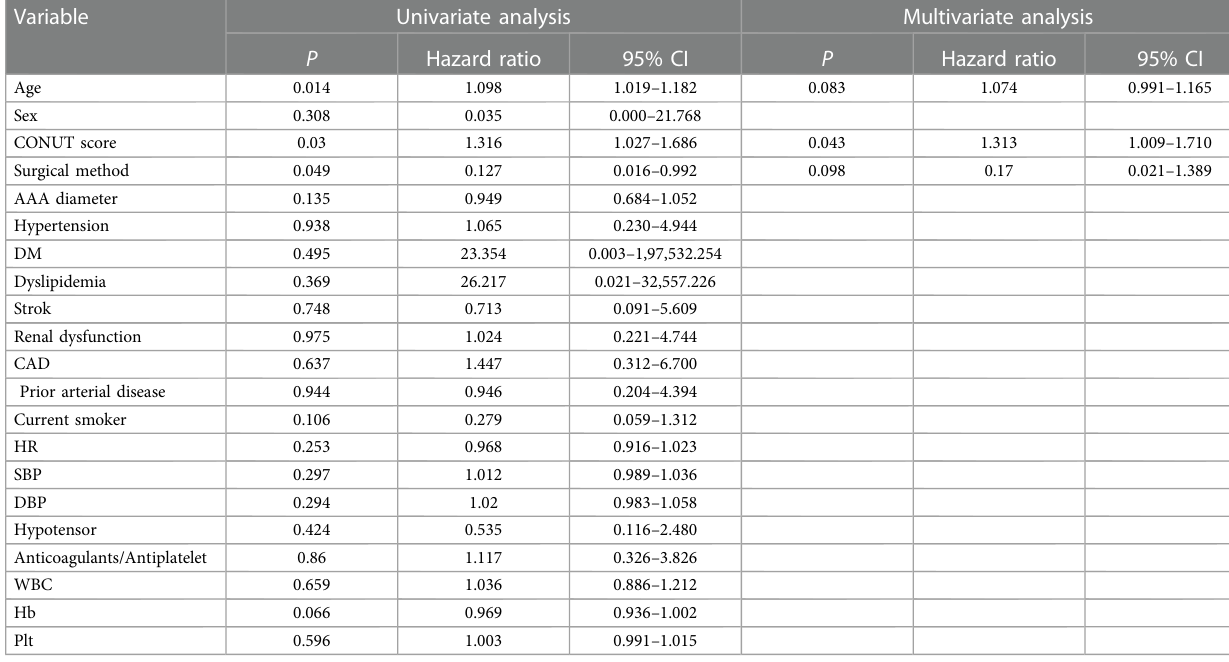
TABLE 5 Cox regression analysis for risks of midterm mortality.